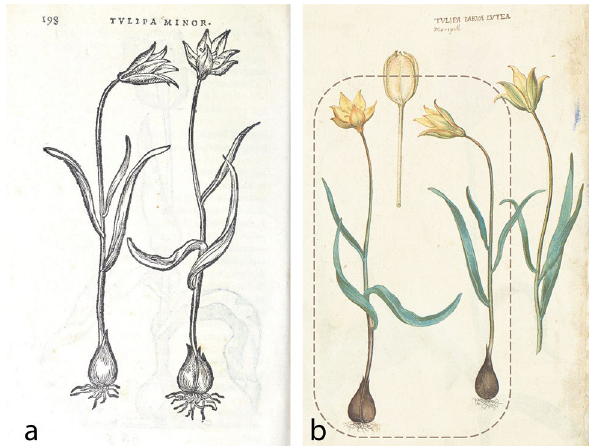
Figure 6. French Tulipa sylvestris came to northern Europe from Montpellier. Plants from this original material are probably depicted in the woodcut that accompanied the first scientific description of T. sylvestris published in 1568 by Rembert Dodoens. Biodiversity Heritage Library ( a ). The model used for this woodcut was a watercolor illustration from 1565-1568/9, which is part of the famous Libri Picturati collection. Jagiellonian Library Krakow, A30.056v ( b